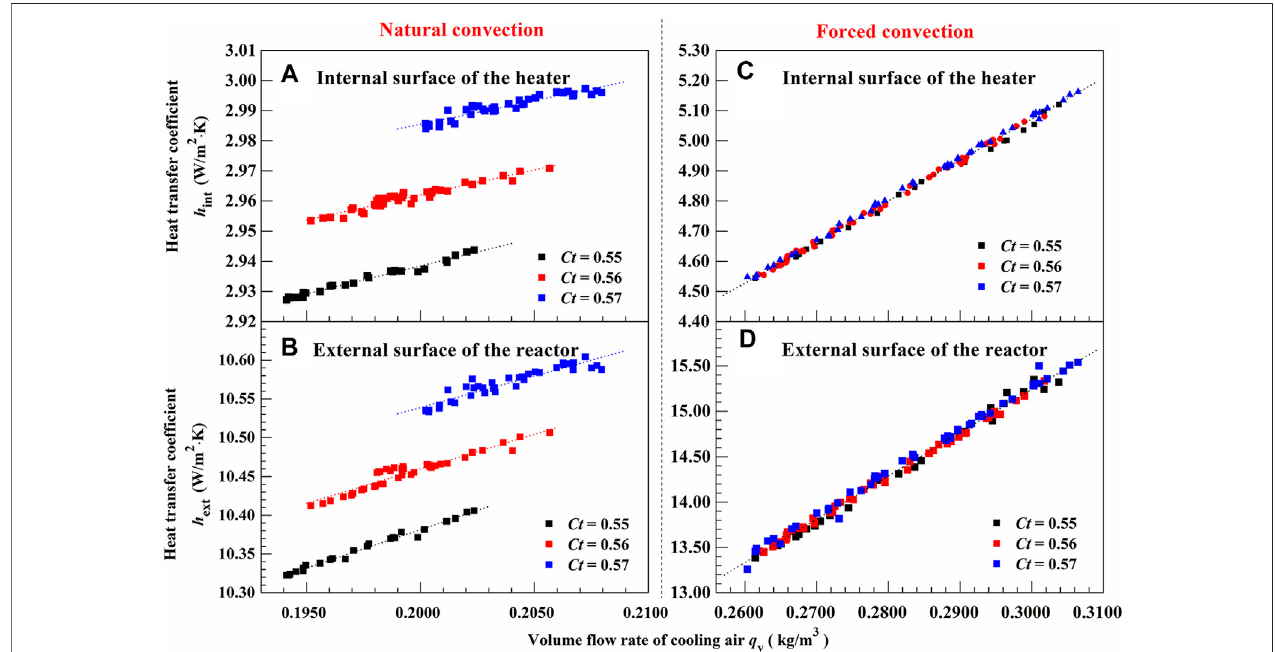
FIGURE 2 | Complex mean heat transfer coef fi cients of the natural convection and the forced convection.